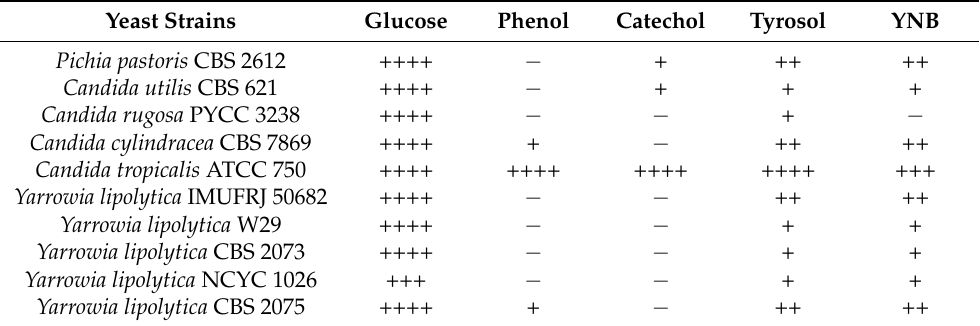
Table 2. Yeast growth on agar plates with different phenolic compounds. Glucose and YNB (no carbon source) were used as control